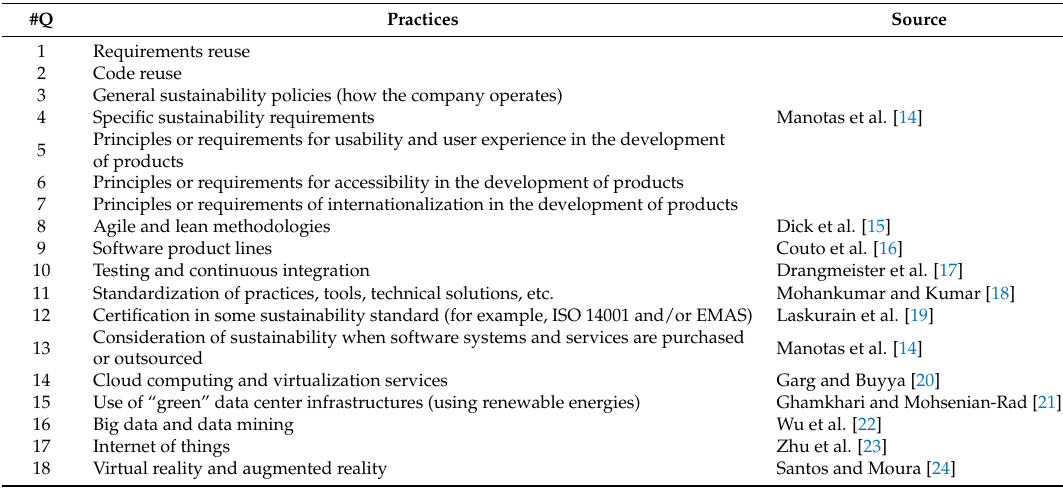
Table 1. Technical practices analyzed in this